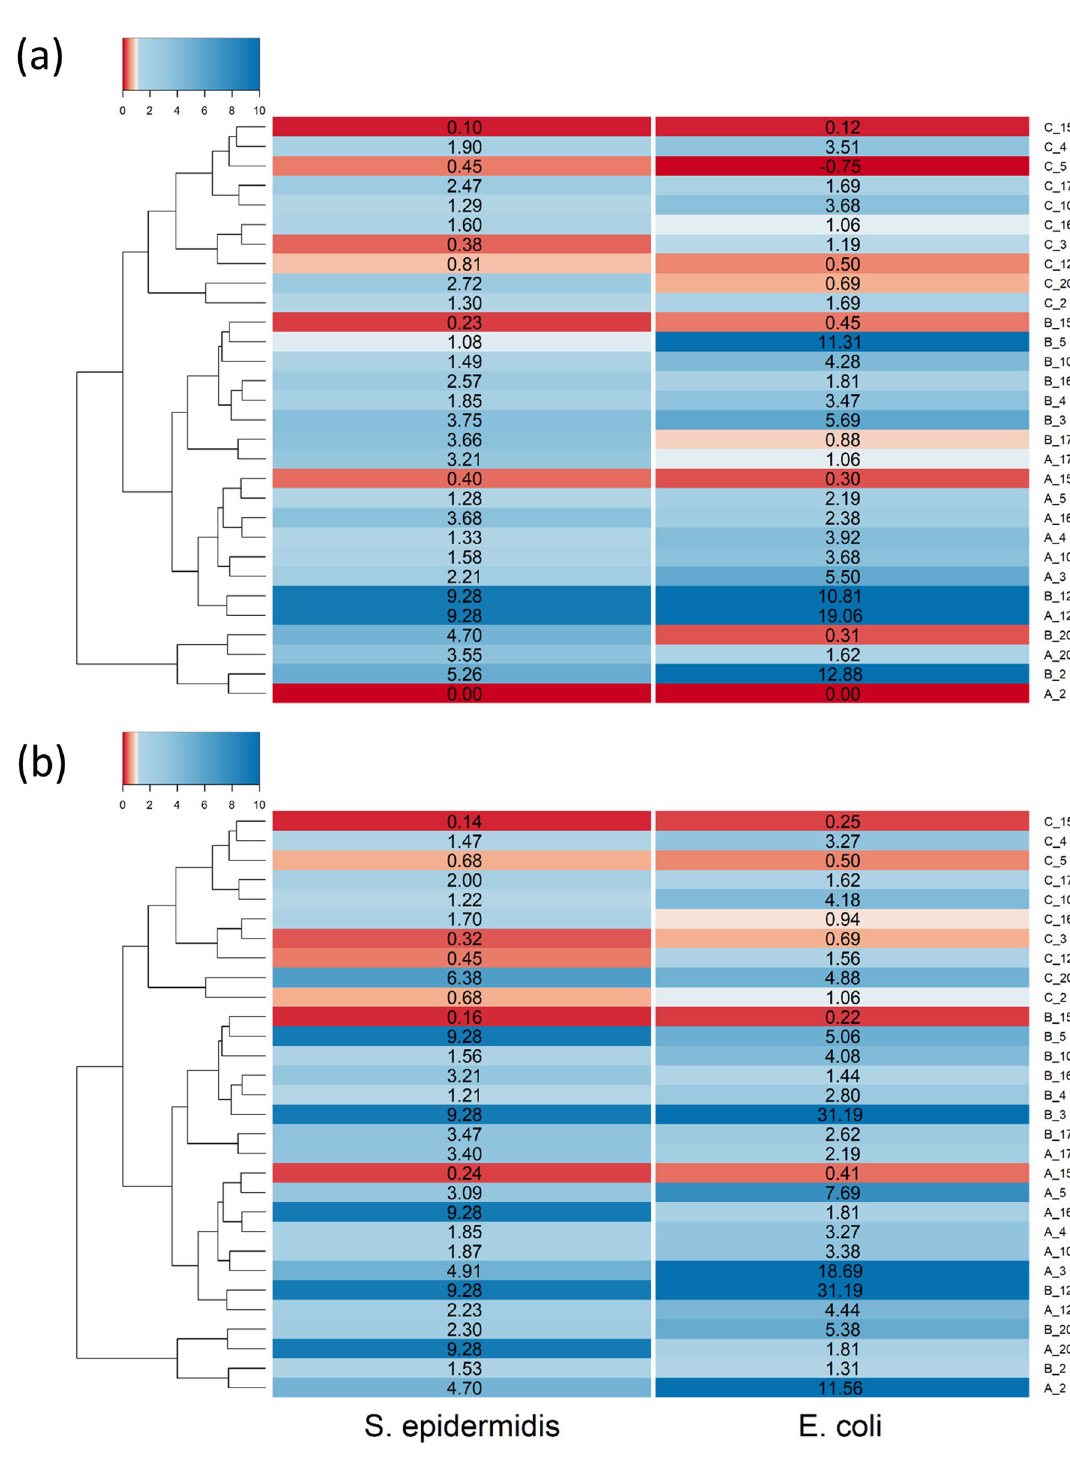
Figure 6. Log 10 reduction of viable cells after 30 s laser exposure of E. coli and S. epidermidis comparted to pure TBO when exposed to different TBO–PBAEs end-capped with ( a ) e1 and ( b )